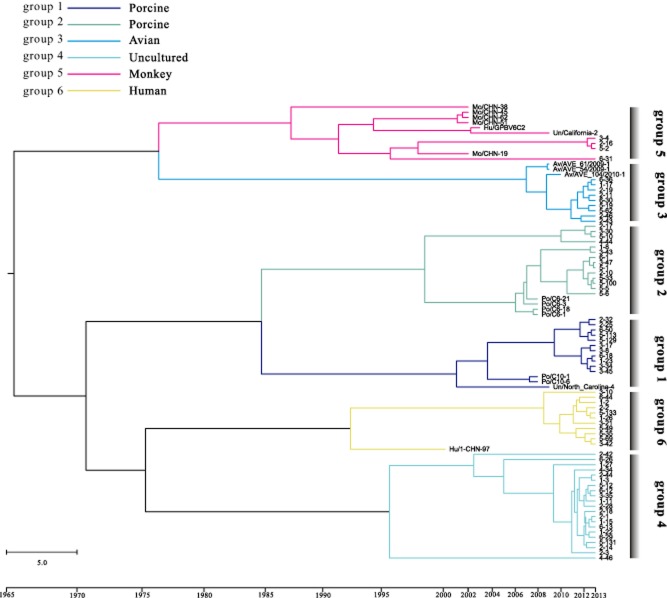
Bayesian maximum credibility (MCC) tree construction based on the sequences of six groups. The branches of different groups were coloured on the basis of different hosts, and at the bottom of the MCC tree represents the years before the last sampling time (2013). Bar, 5 years. The scale on the upper left of the MCC tree showed the different colours of different groups and hosts.